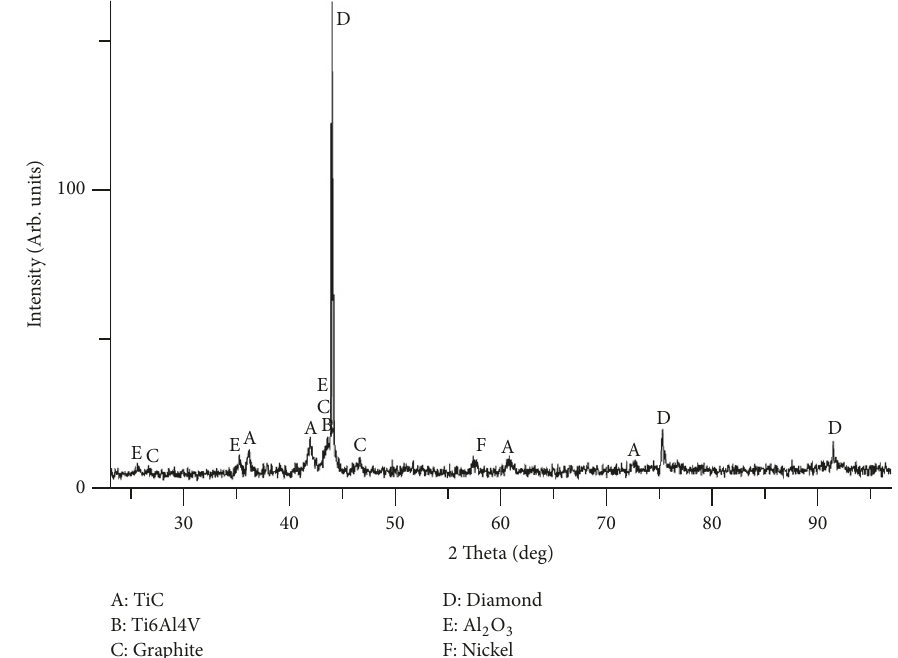
Figure 7: An exemplary XRD diffraction pattern of sample No. 1 before wear